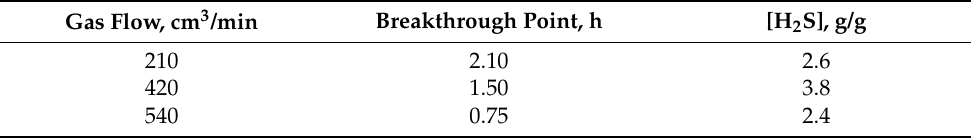
Figure 3. Experimental (points) and model (lines) breakthrough curves at various gas flows. H 2 S dosage: 400 mg. Adsorbent dosage: 4 g. Temperature: 20 °C.